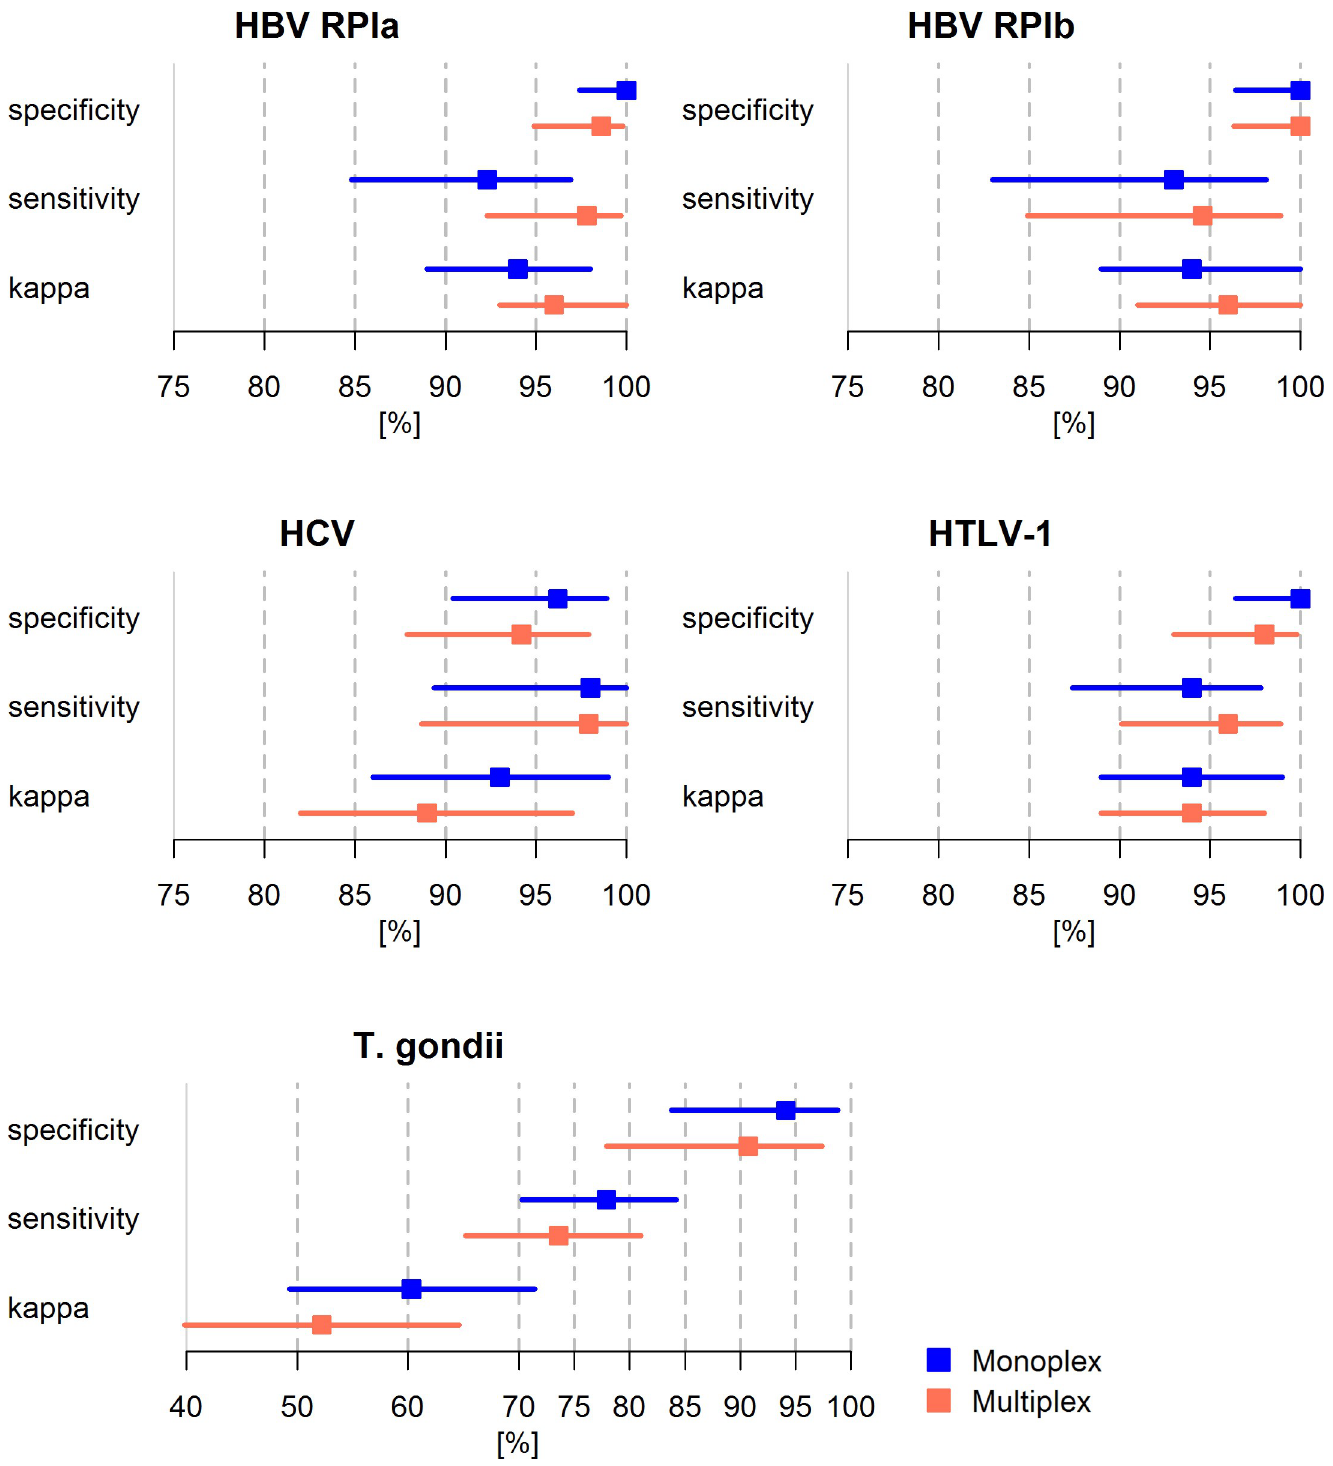
Fig 2. Statistical performance of pathogen-specific assays (overall seropositivity to HBV, HCV (AND/OR), HTLV-1, T . gondii ) in monoplex (blue) and multiplex (orange) format. To enhance visualization, Cohen’s kappa statistics are illustrated as percentages. Sensitivity, specificity and Cohen’s kappa statistics are illustrated by boxes while the corresponding 95% CI is indicated by horizontal lines. Performance of Monoplex and Multiplex Serology was directly compared on the corresponding reference panel using ICCs. The comparison yielded moderate to excellent reliability between monoplex and multiplex format: ICC HBV RPIa : 0.94 (95% CI 0.92–0.95), ICC HBV RPIb : 0.97 (95% CI 0.96–0.98), ICC HCV : 0.97 (95% CI 0.96–0.98), ICC HTLV-1 : 0.94 (95% CI 0.92–0.95), ICC kappa: Cohen’s kappa . ICC: Intraclass correlation coefficient. CI: confidence interval. RP: reference panel. https://doi.org/10.1371/journal.pone.0210407.g002 PLOS ONE | https://doi.org/10.1371/journal.pone.0210407 January 7,